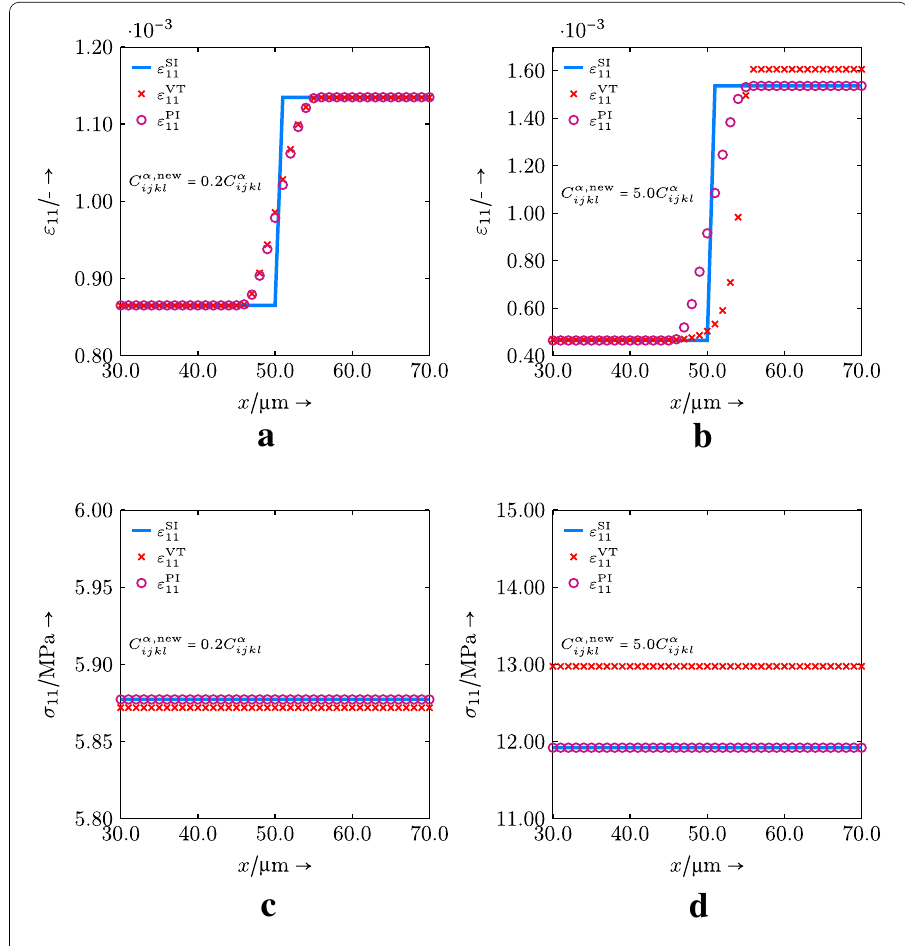
Fig. 10 Influence of differently stiff material behaviour: Results for a , b ε 11 and c , d σ 11 compared to a sharp-interface solution at t = 20s. The results of a less stiff elastic phase α are depicted in a and c , while stiffer material behaviour is shown in b and d . The quantities are plotted along x with y = 49 . 5 µ m